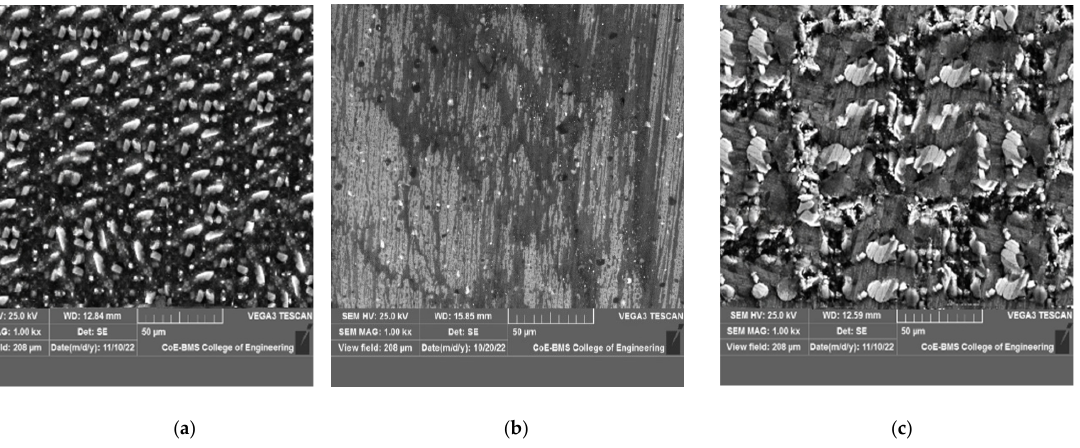
Figure 8. SEM images of a FSPed AA7075/ Gr sample prepared at ( a ) 800 rpm and 35 mm/min, ( b ) 1000 rpm and 35 mm/min, and ( c ) 1400 rpm and 25 mm/min.